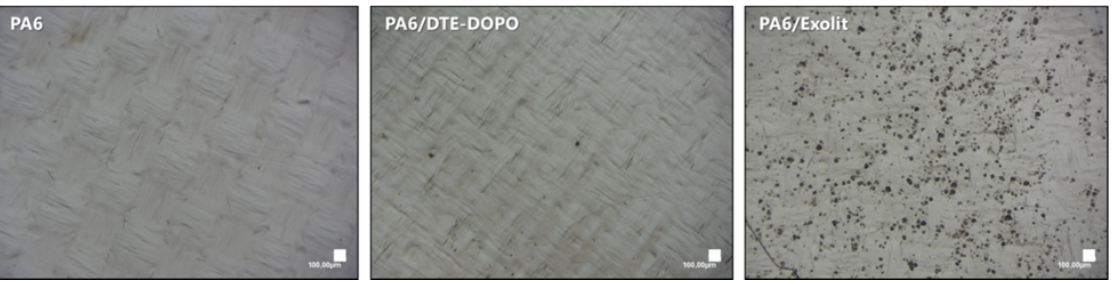
Figure 5. Transmission optical microscope images of the films prepared from PA6, PA6/DTE-DOPO, and PA6/Exolit formulations by hot compression at 240 °C for 5 min. Bar scales represent 100 µm. For the PA6/Exolit formulation the black points of the image account for the distribution of the Exolit particles within the PA6 matrix.